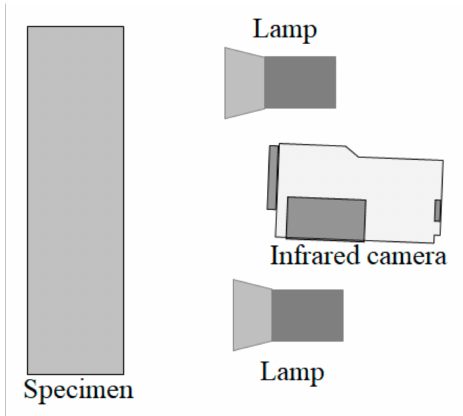
Figure 2. Scheme of the lock-in thermography setup.